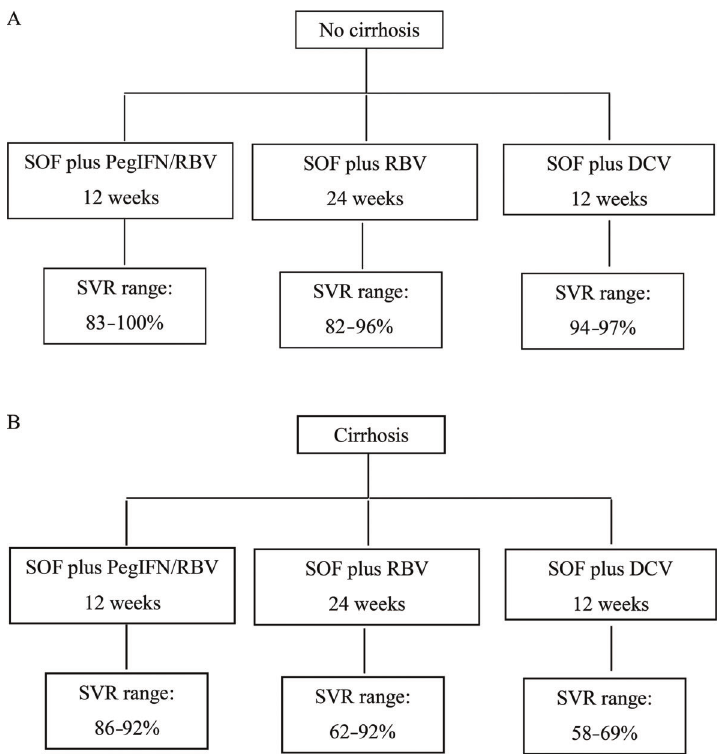
Figure 1. Sustained virological response (SVR) rates among patients with hepatitis C virus (HCV) geno- type 3 infection. A , SVR rates among patients without cirrhosis and B, among patients with cirrhosis, according to different therapeutic regimens. PegIFN: pegylated interferon; SOF: sofosbuvir; DCV: dacla- tasvir; RBV: